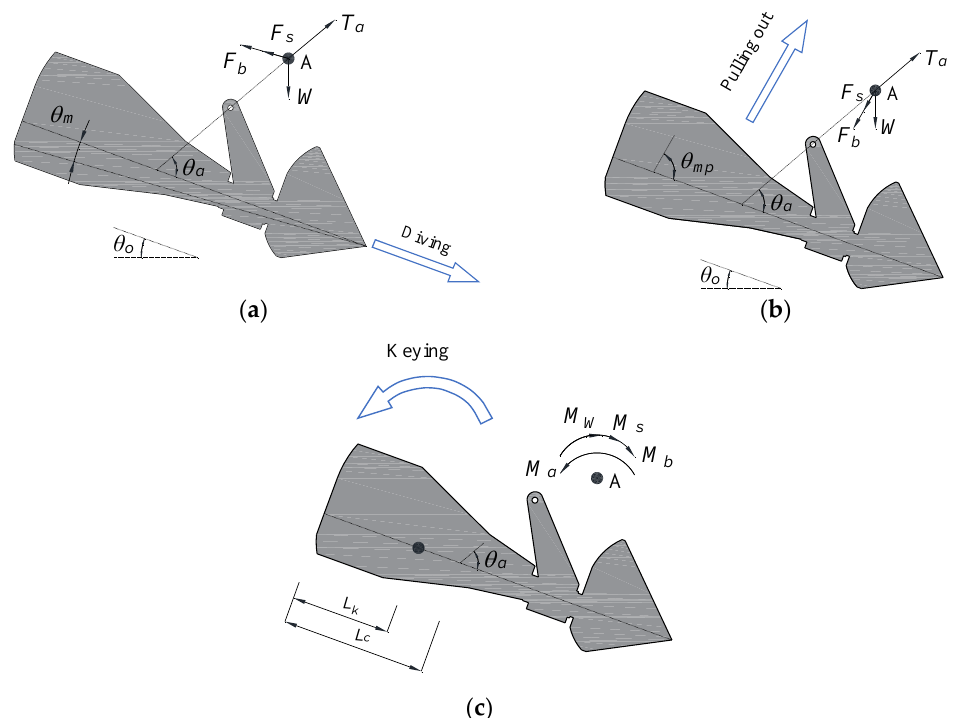
Figure 3. Definition of drag anchor behaviors and mechanical model: ( a ) Diving; ( b ) Pulling out; ( c ) Keying.